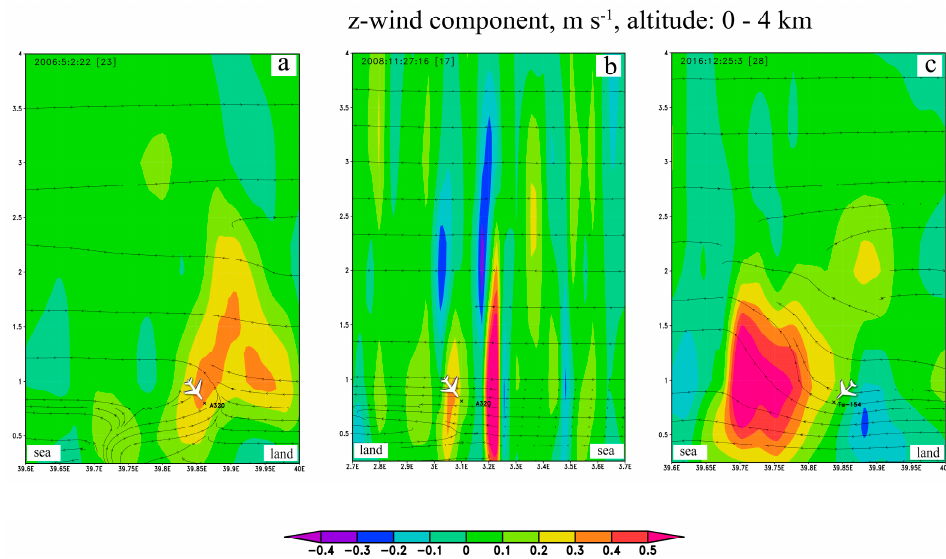
Figure 6. The vertical cross-sections of the z-wind component in the 0–4 km layer for crash sites: ( a ) A320-211, Russia, 2006; ( b ) A320-232, France, 2008; ( c ) Tu-154, Russia, 2016. The aircraft crash sites are indicated by markers. Additionally, the ( u , w ) wind streamlines and the sea–land directions are specified.